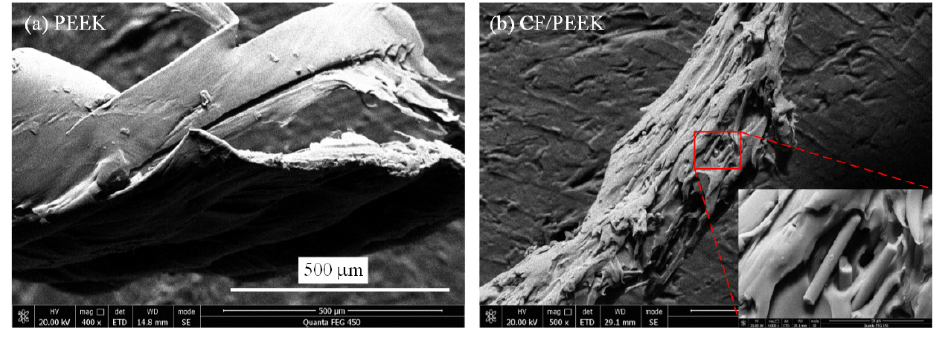
Figure 17. Chip morphologies of PEEK and CF/PEEK samples.